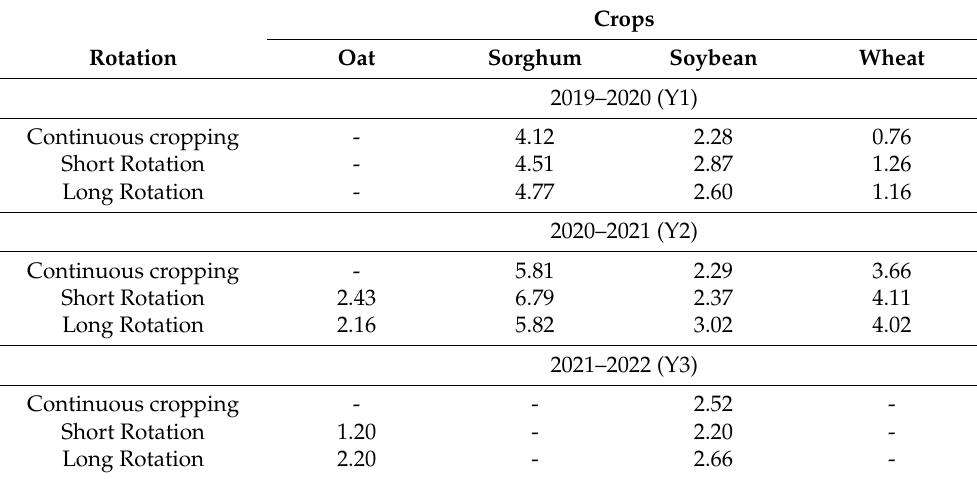
Table 4. Grain yield (t/ha) for crops in the ‘Palo a Pique’ pasture–crop rotations long-term experiment in Treinta y Tres, Uruguay (2019/2020, 2020/2021 and 2021/2022). Crops Rotation Oat Sorghum